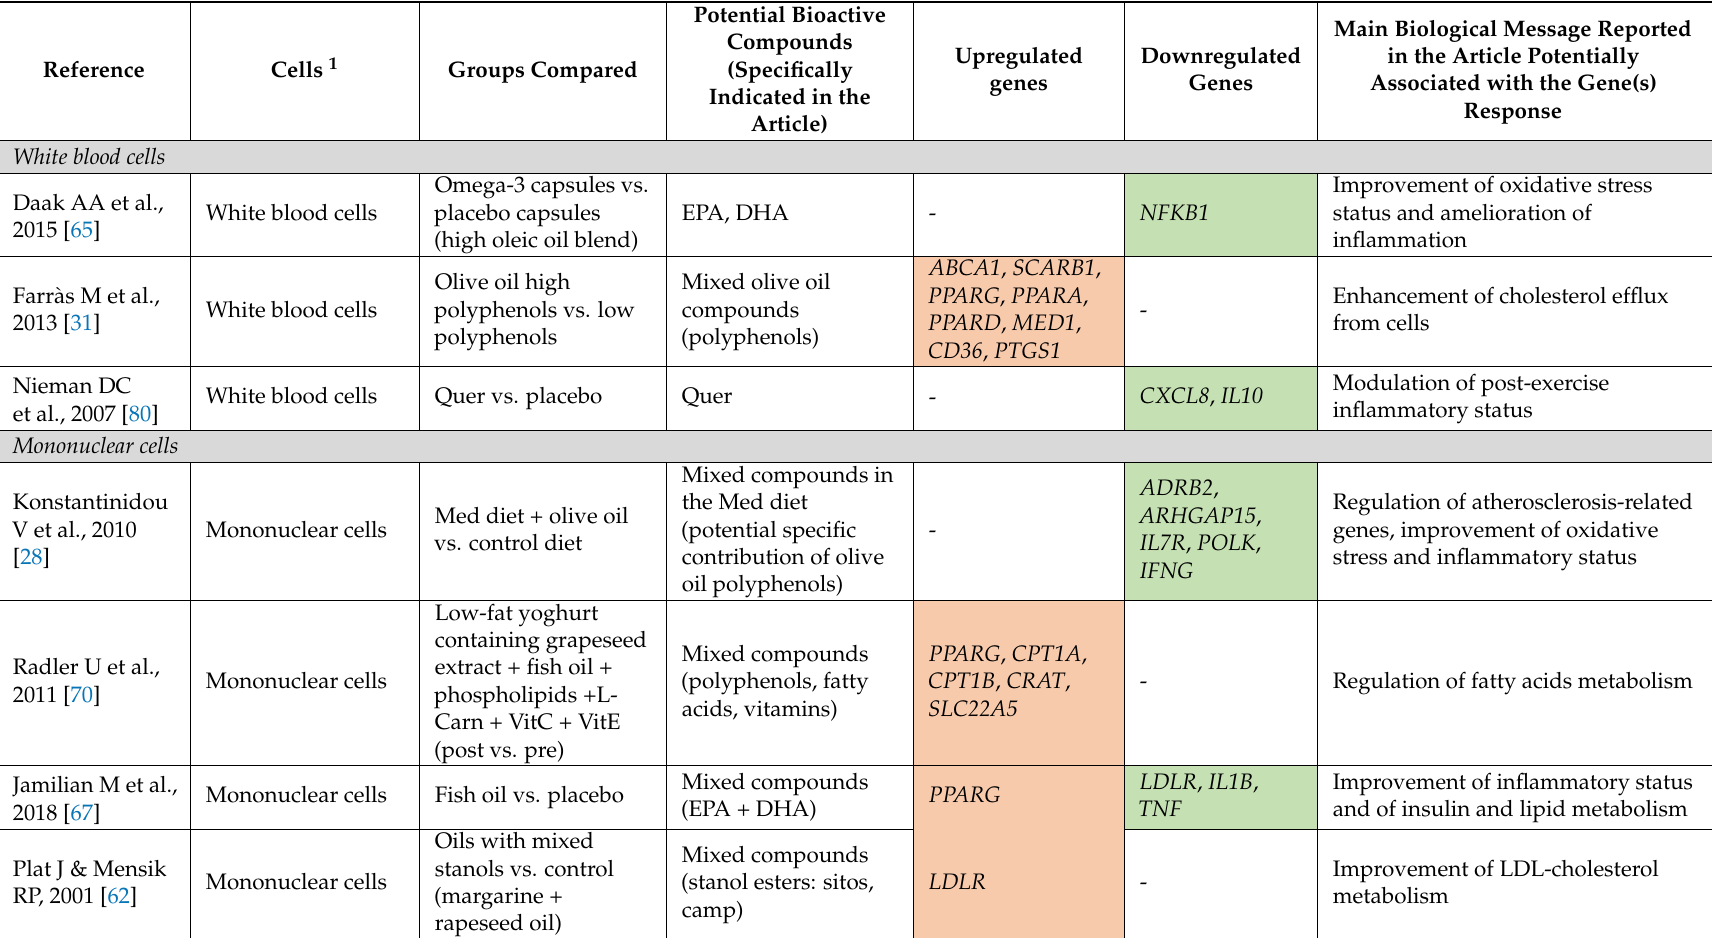
Table 2. Overview of the significant gene expression changes reported in peripheral blood isolated immune cells in response to different interventions with various diets, foods, or derived products containing bioactive compounds ( p -value <